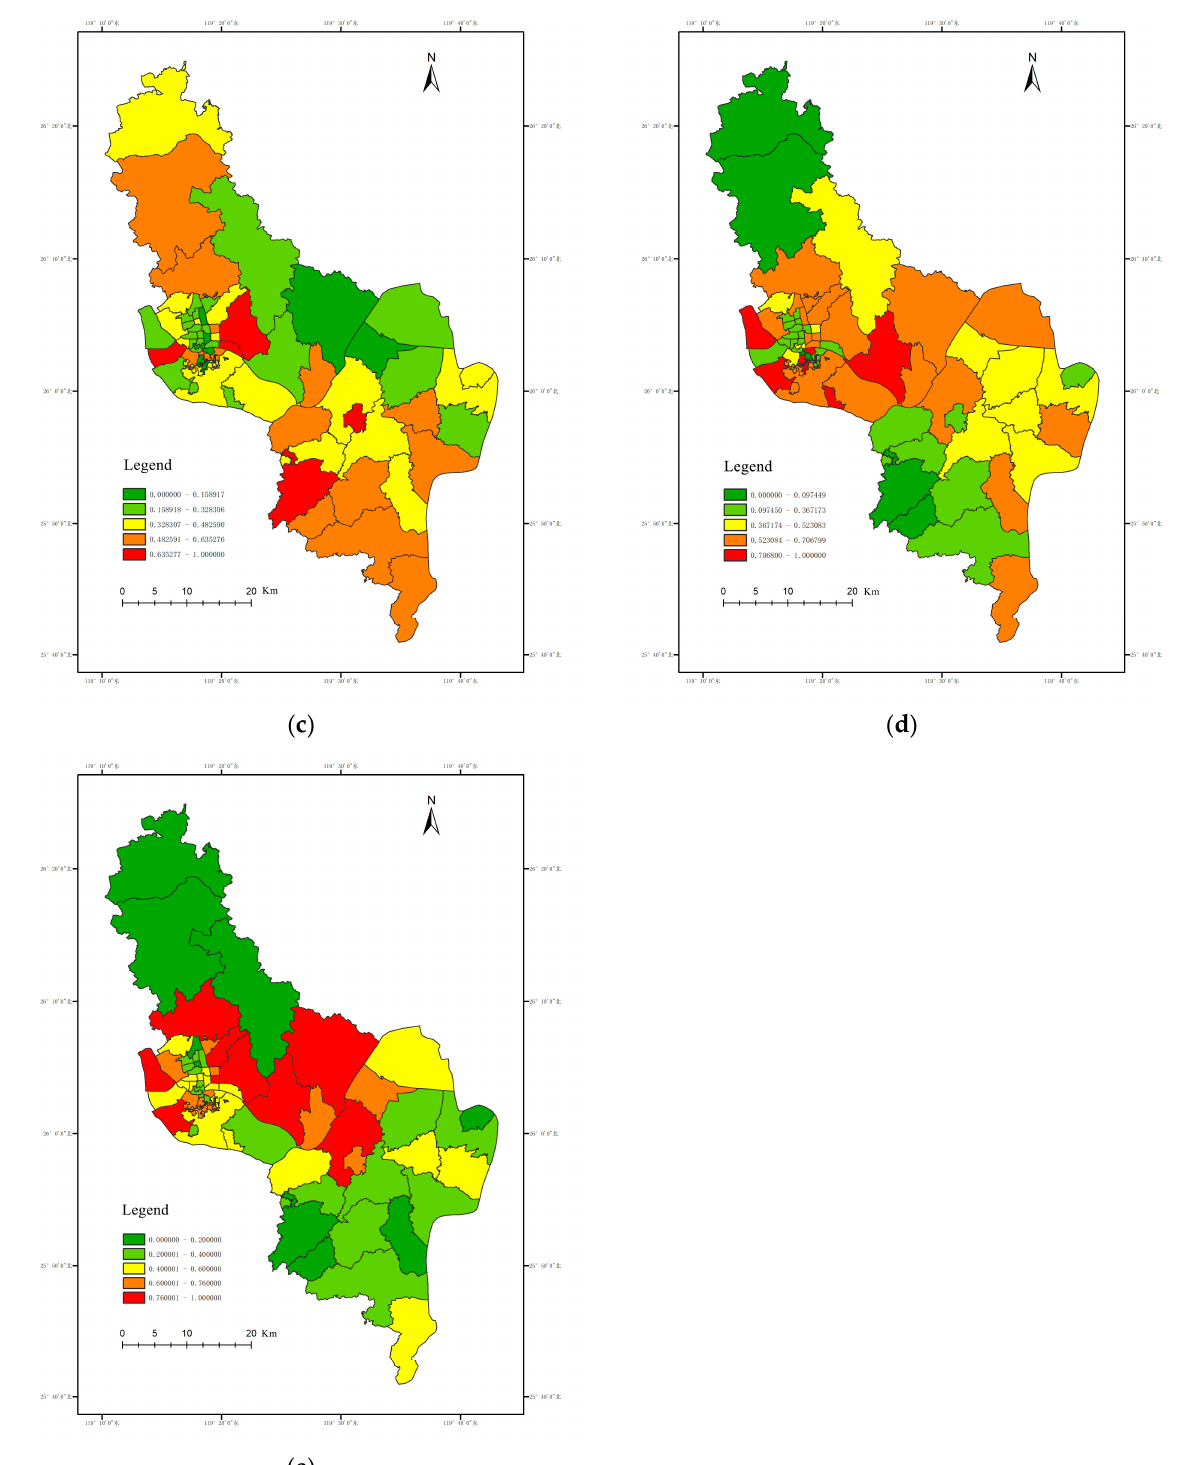
Figure 16. Index of green space demand in urban areas of Fuzhou: ( a ) total population; ( b ) female population; ( c ) population aged 0 to 14; ( d ) aged 65 and above; and ( e ) foreign population. Table 10. Green space demand index in Fuzhou city (blocks).